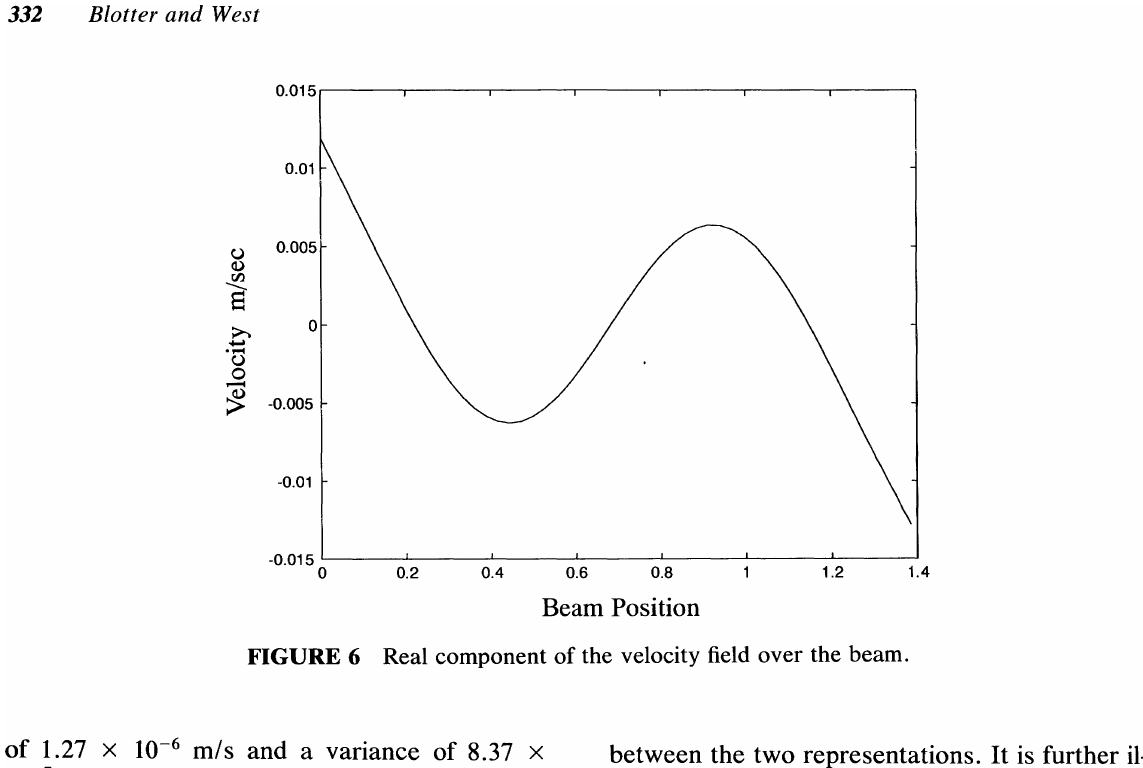
FIGURE 6 Real component of the velocity field over the beam.